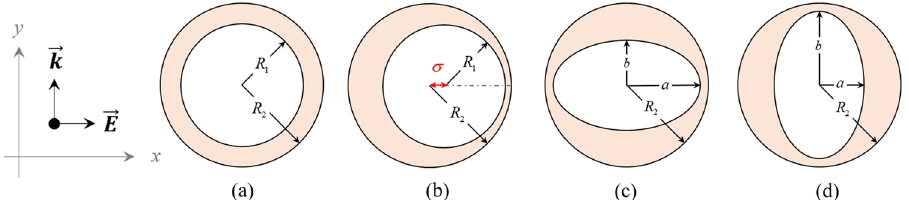
Figure 1. Schematic diagram of asymmetric nanoshells including ( a ) core–shell; CS, ( b ) nanoegg; NE, ( c ) prolate core in spherical shell; PS and ( d ) oblate core in spherical shell;